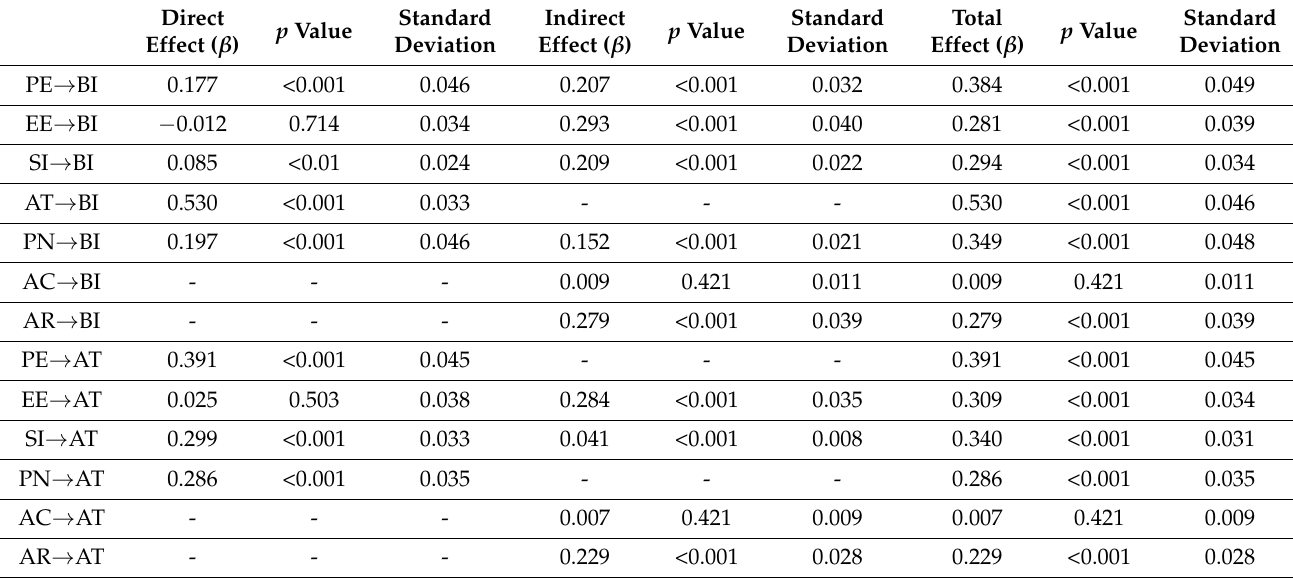
Table 6. The effects of predictors on BI and AT.